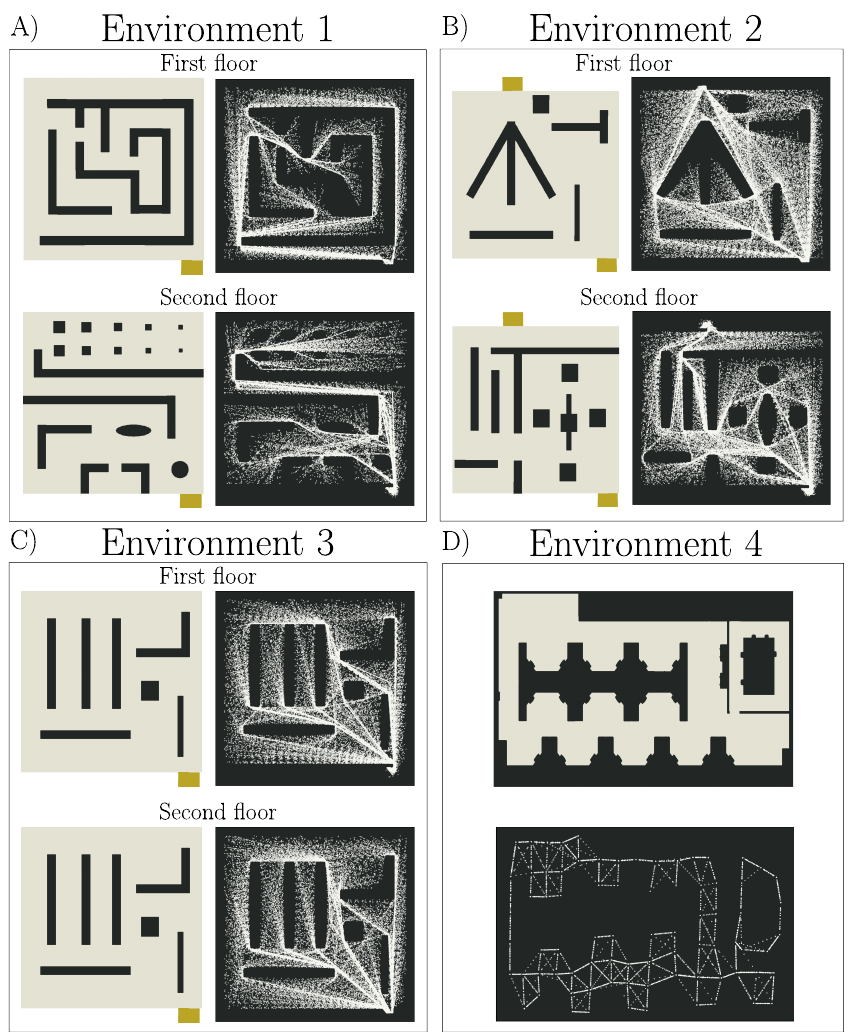
Figure 1. ( A – D ) show illustrated information from Environments 1, 2, 3, and 4 respectively. Images with a white background represent the modeled environments, with obstacles highlighted in gray. In ( A – C ) there are also yellow squares, which represent access stairs from one floor to the other. In images with a black background, each white dot represents a place where an object was during its